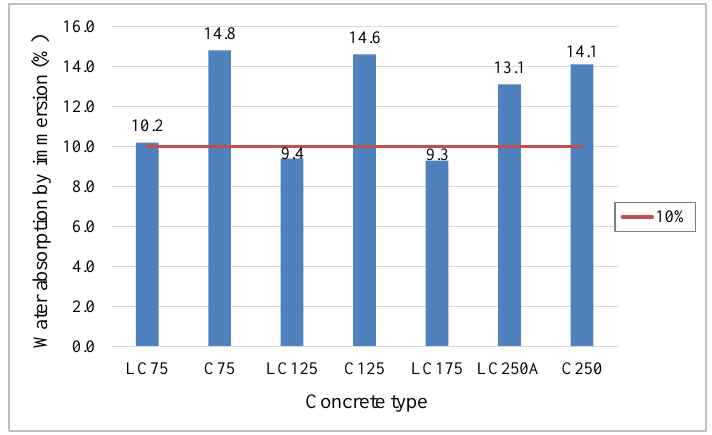
Figure 12. Average values of water absorption by immersion.